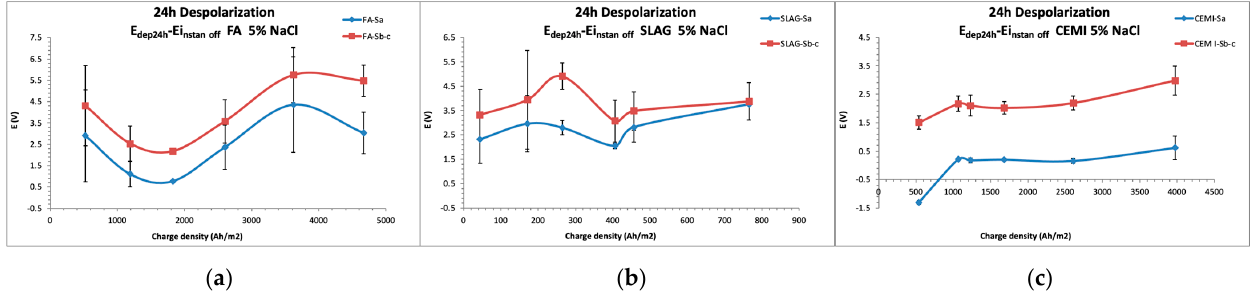
Figure 5. The 24 h depolarized potential averaged values registered during the treatment and standard deviation. ( a ) FA specimens; ( b ) SLAB specimens and ( c ) CEM I specimens.